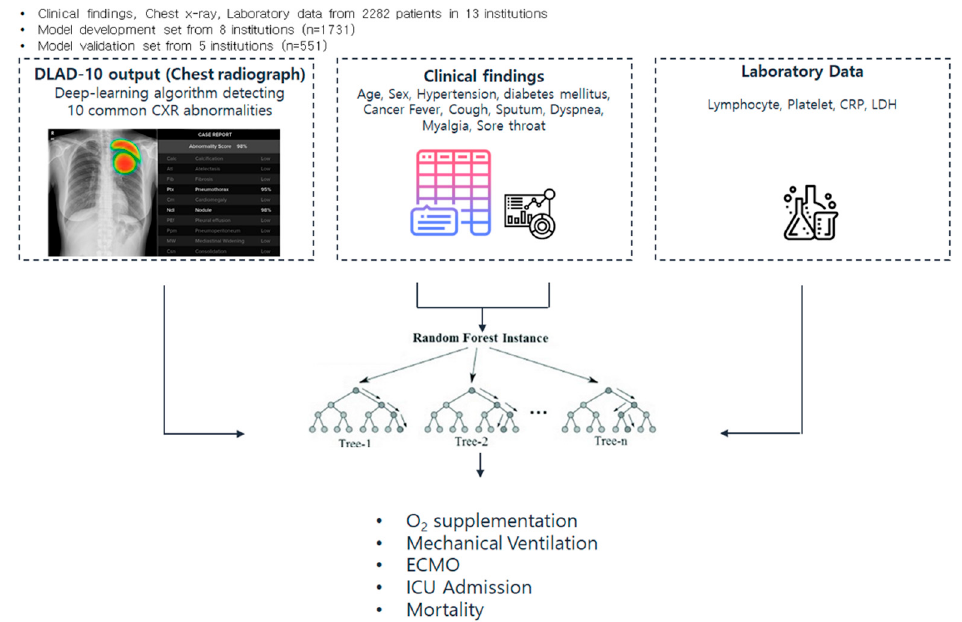
Figure 1. Schematic of the study workflow and performance of risk prediction